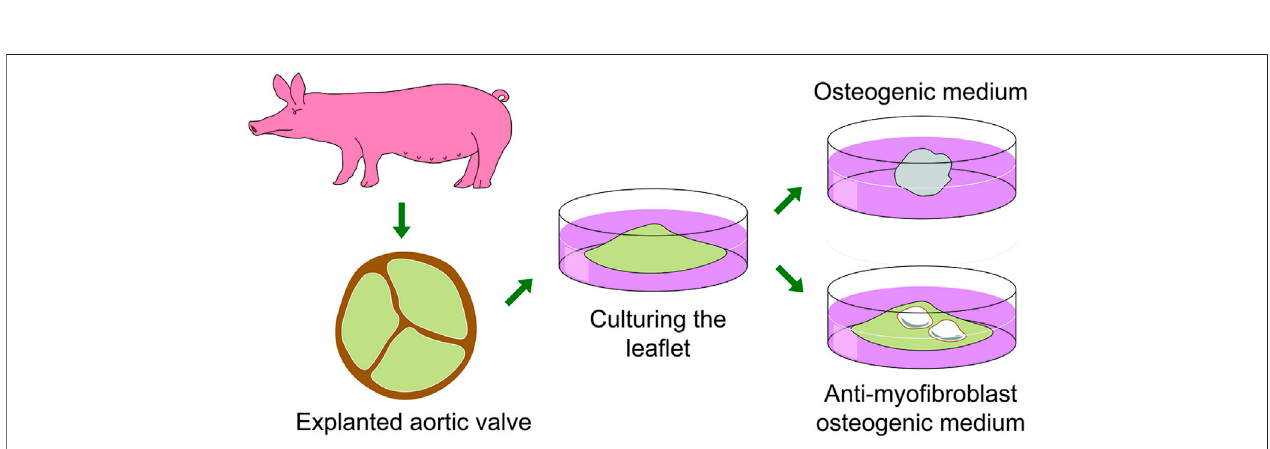
FIGURE 9 | A schematic overview of the whole pig lea fl et cultivation and calci fi cation model with the effect of standard osteogenic and anti − myo fi broblast media being used.